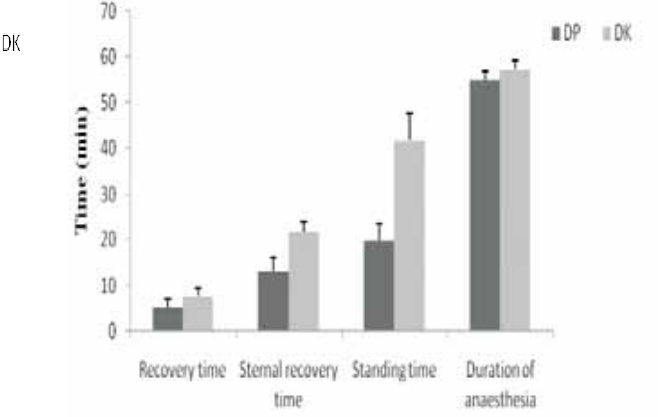
Figure-3: Mean±SE score for pedal reflex in the animals of groups DP and DK at different time intervals. Table-2: Mean±SE of HR, RR, RT & MAP values obtained before treatment (baseline), immediately after sedation (sedation) and during anaesthesia. Time